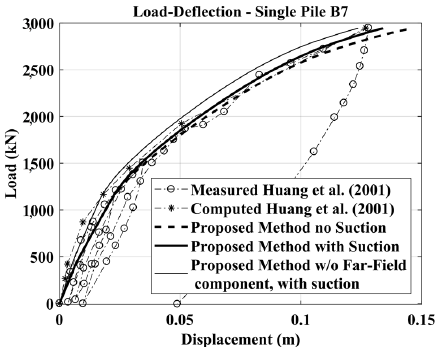
Figure 10. Comparison of measured and computed (Huang et al. [43] and proposed method) Lateral Load vs. Head Deflection curve.